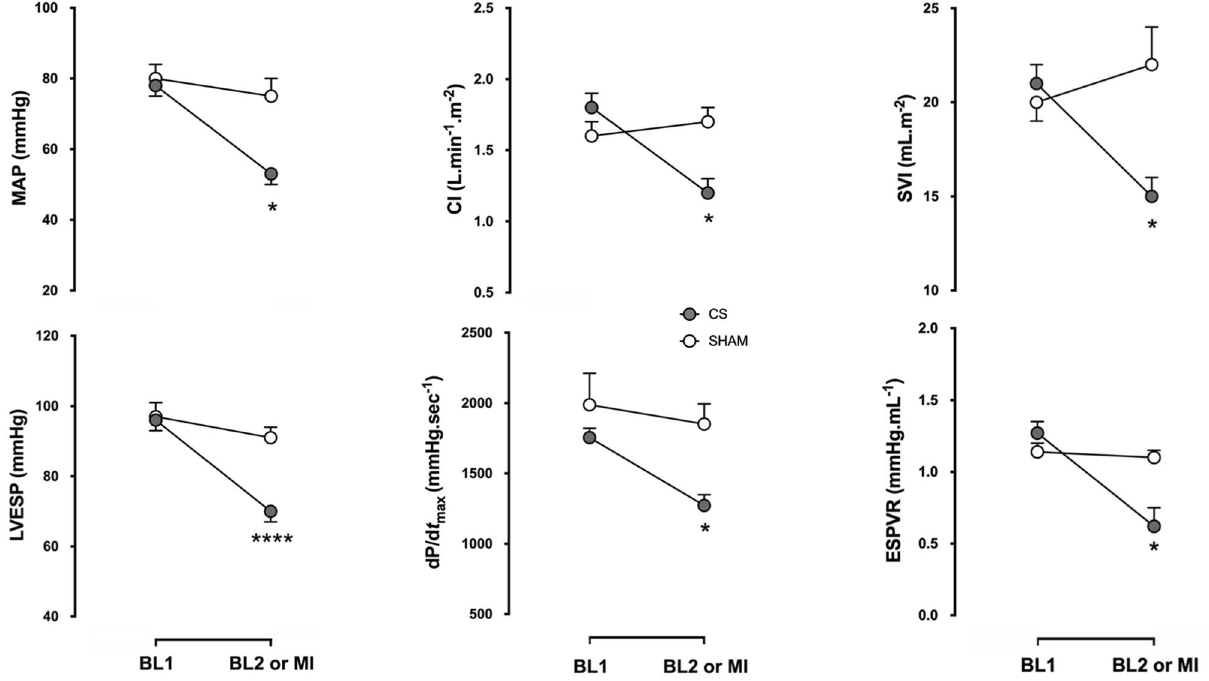
Figure 2. Changes in haemodynamic parameters between baseline 1 (BL1) and baseline 2 (BL2) in SHAM (open circles) and SHOCK (closed circles) groups are presented as mean ± SEM. Representative data from n = 17 CS and n = 8 SHAM animals is presented. A paired Sudent’s t test was used to compare two mean values. *p<0.05 versus BL1. MAP mean arterial pressure, CI cardiac index, SVI Stroke volume index, LVESP Left ventricular end-systolic pressure, dP/dt max maximal positive left ventricular pressure derivative, ESPVR End-systolic pressure-volume relationship, MI myocardial